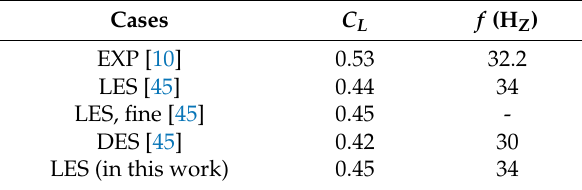
Figure 2. The geometry of two hydrofoils in side view: ( a ) NACA0009; and ( b ) Clark-y.